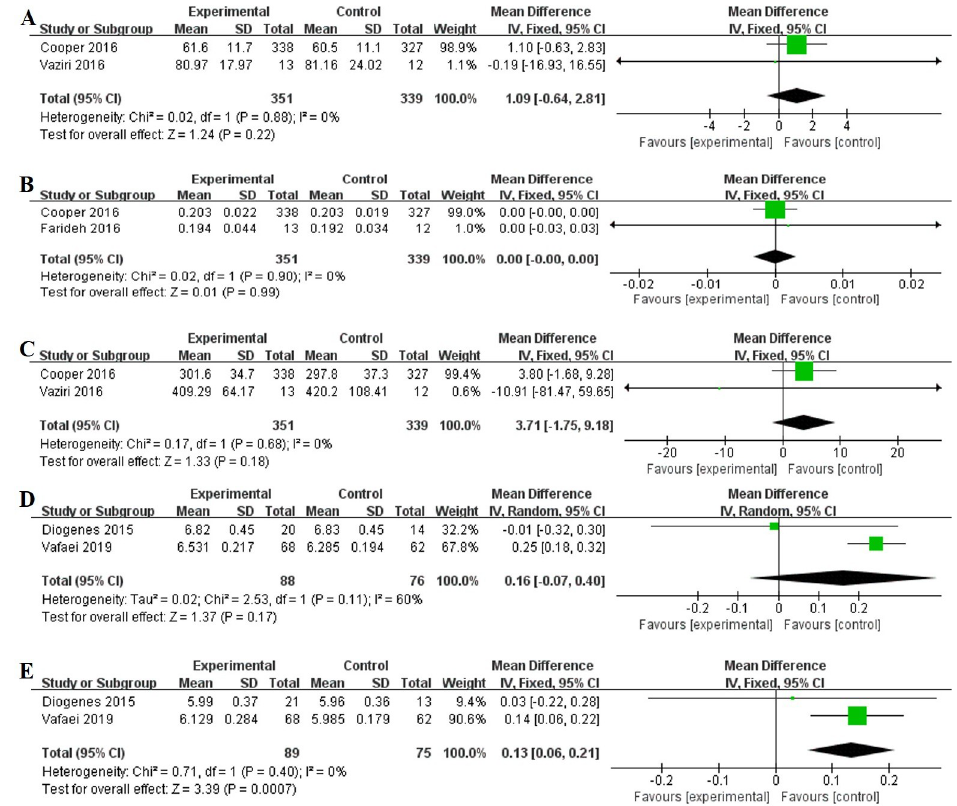
Fig 3. Forest plots of summary crude risk ratios of the association between vitamin D supplementation during pregnancy on bone development assessment of offspring. Notes: A, WB-BMC in neonates; B, WB-BMD in neonates; C, WB-BA in neonates; D, FL in the offspring during the fetal period (third trimester); E,HL in the offspring during the fetal period (third trimester).